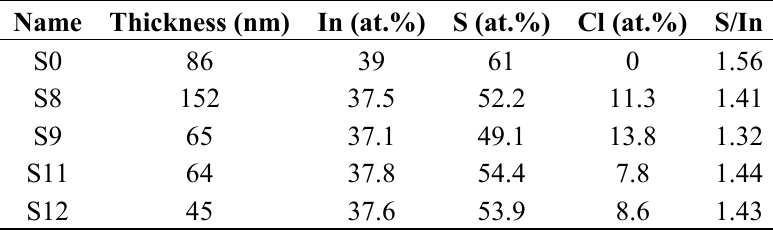
Table 1. Thickness and layer composition of In 2 S 3